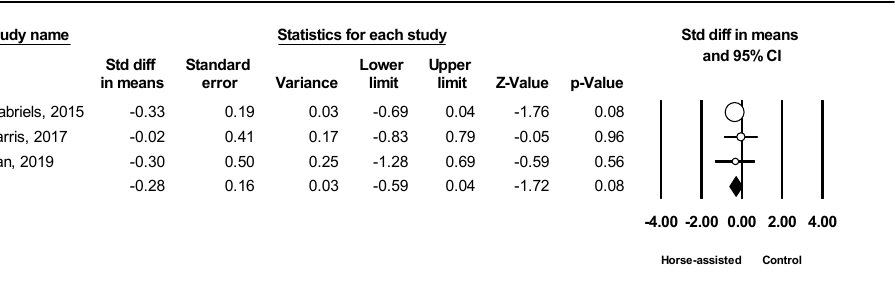
Figure 10. Forest plot showing the effects of horse-assisted therapy vs. control on inappropriate speech [44–46].